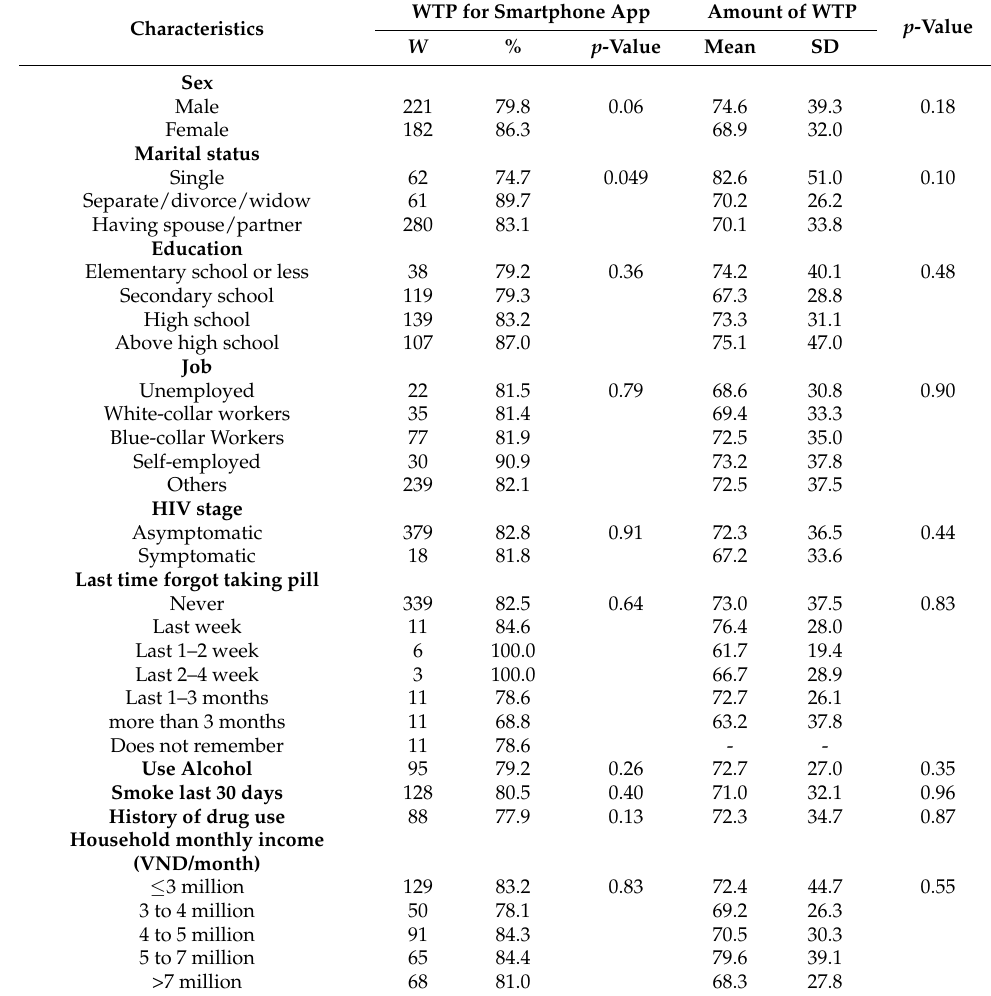
Table 3. WTP and amount of WTP according to the different socio-demographic and clinical